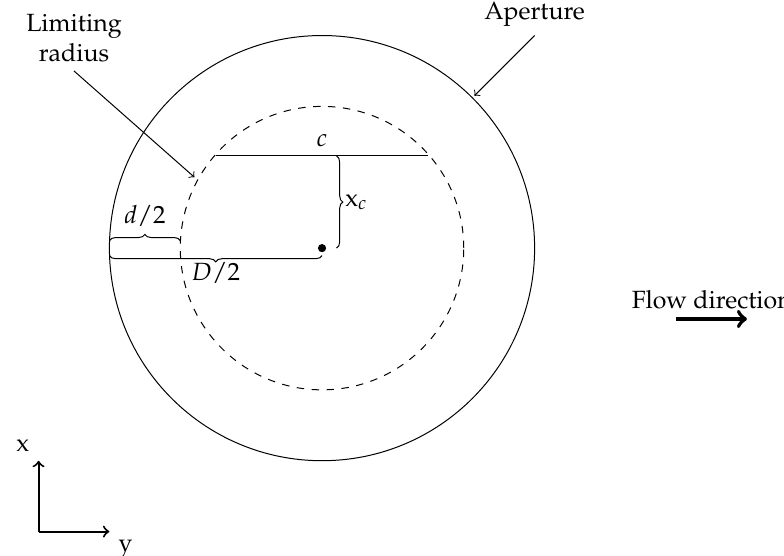
Figure 2. Illustration of how the different parameters needed for theoretical calculations regarding incomplete sampling relate to one another, where D and d represent detector aperture and particle diameter, respectively, and x c represents the distance from aperture center to particle center in the x -direction. For particle positions further away than the limiting radius, an incomplete sample will